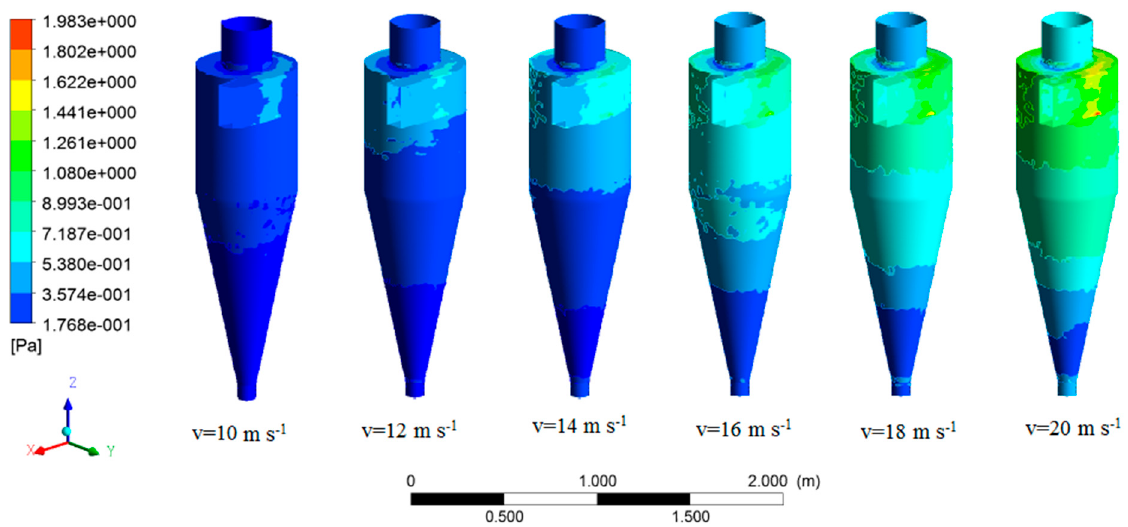
Figure 17. Wall shear 3D contour in various inlet velocities.